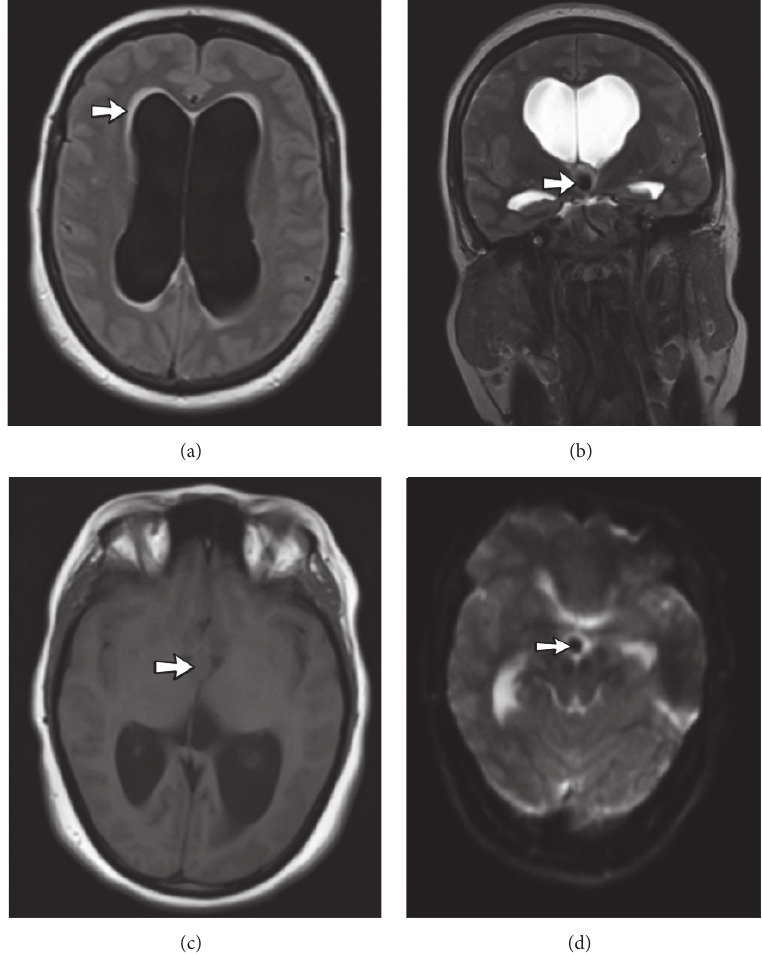
Figure 2: Brain MRI. Axial FLAIR image (a) shows enlargement of lateral ventricles. The hyperintense rim around the ventricles represents interstitial edema secondary to acute hydrocephaly. Coronal T2-weighted image (b) reveals a round hypointense lesion at the location of interventricular foramen of Monro (arrow in (b)). The lesion (arrow in (c)) is isointense in the axial T1-weighted image (c). The size of the lesion is exaggerated in the b0 sequence of DWI image (d); a finding that suggests hemorrhage (arrow in